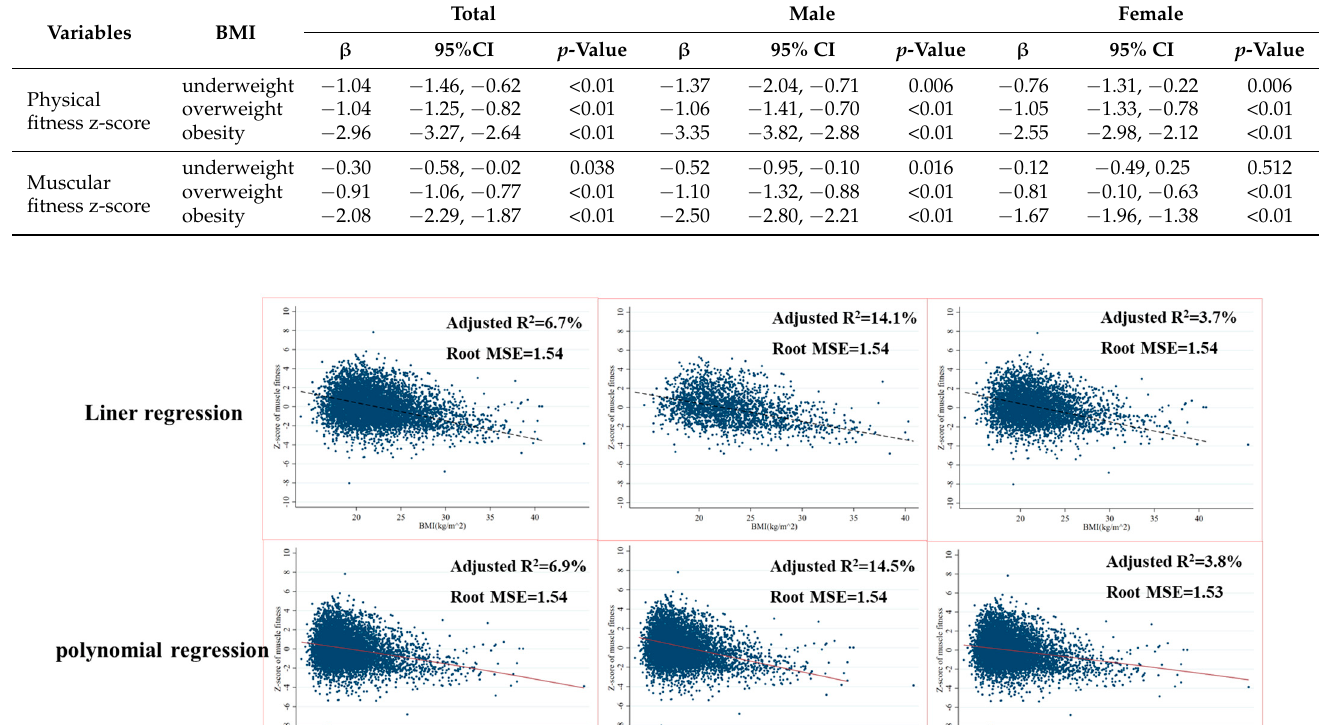
Table 4. Linear regression analysis for physical fitness and weight status in college students.